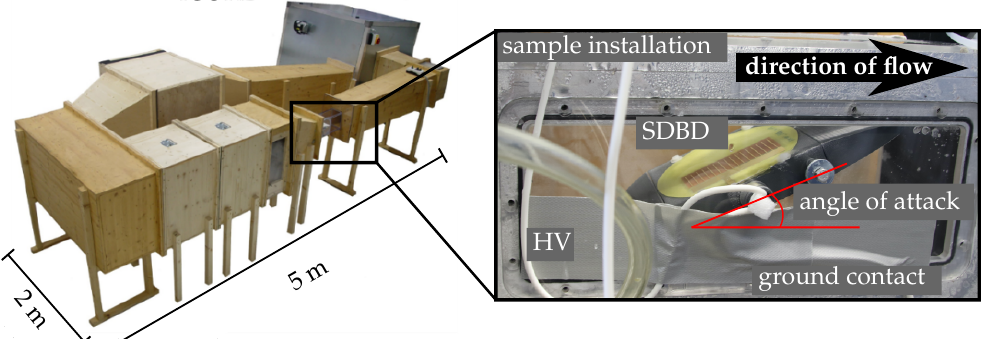
Figure 9. The iCORE, the used icing and contamination research test facility. The left side depicts the whole setup with the air acceleration and cooling system. The right shows an image of the test section with a SDBD sample mounted to an